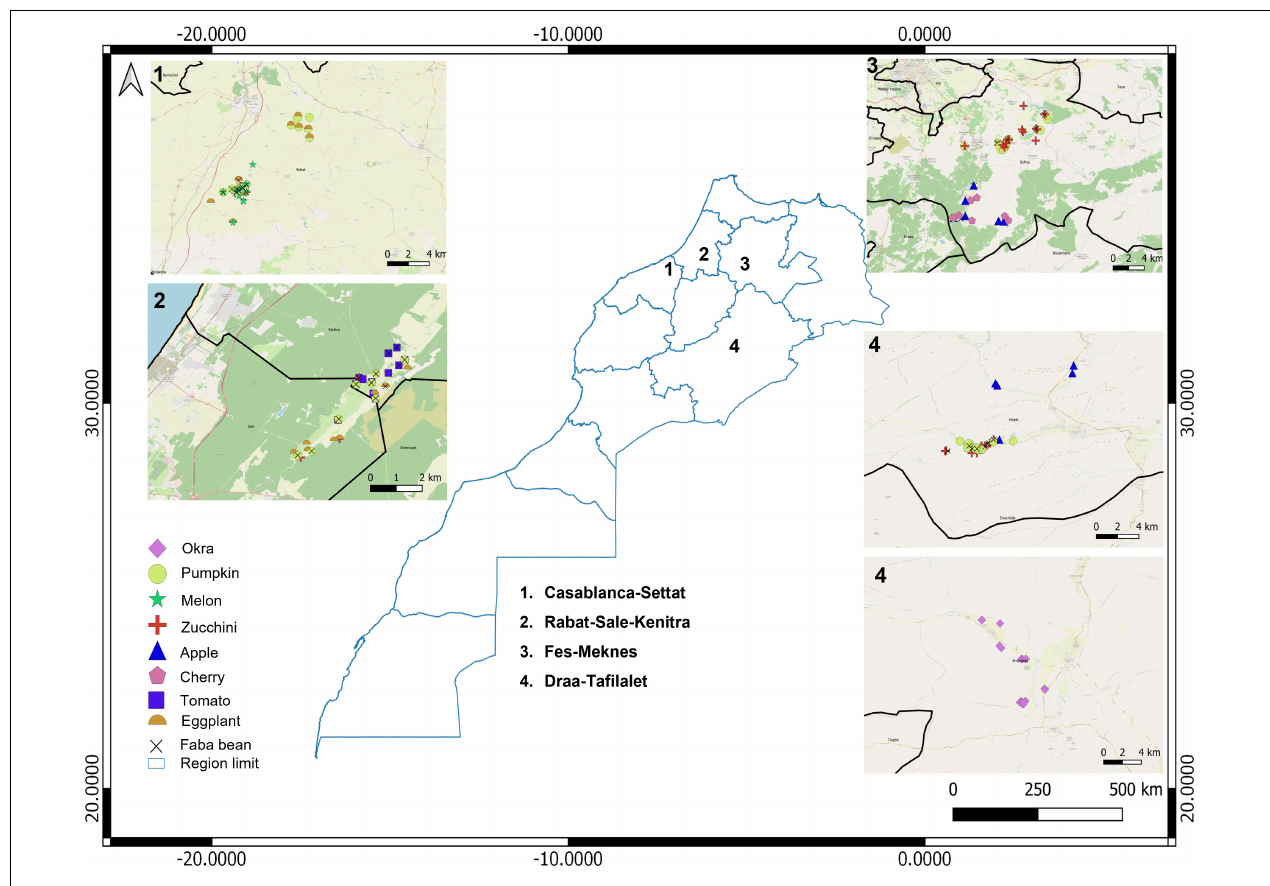
FIGURE 1 | Map of Morocco indicating locations of crop